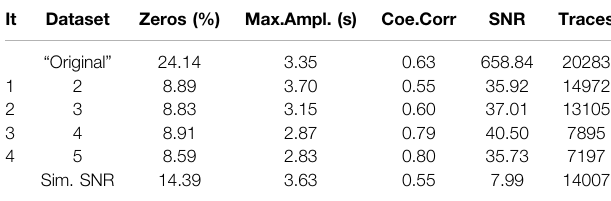
TABLE 1 | Comparison between selection parameters at each selection iteration and relative to the signal-to-noise ratio.